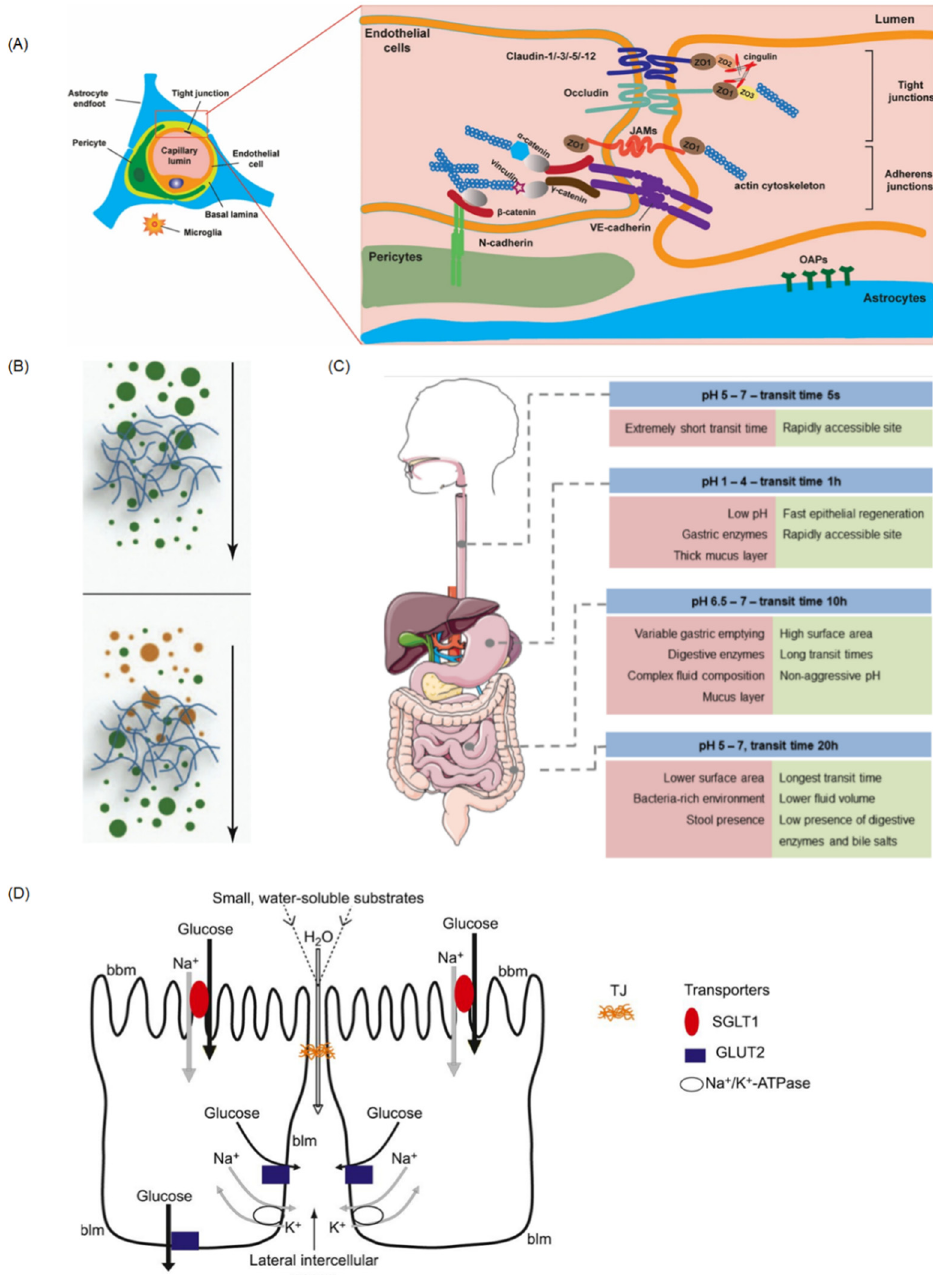
Figure 4. ( A ) Cells association at and molecular organization of the neurovascular unit (NVU). ( B ) The steric ( left ) and interactive ( right ) barrier properties of mucus. The mucus forms a filter, which can prevent diffusion across the gel according to size ( left ) or surface properties ( right ) of the diffusing compound. ( C ) Schematic representation of GIT sections and their pH, transit time, and relevant parameters for drug delivery. ( D ) Schematic diagram illustrating glucose absorption by transcellular pathways and paracellular pathways. Reprinted and adapted with permission from: ( A ) Kadry et al. [89], ( B ) Lieleg et al. [108], ( C ) Alonso et al. [129], and ( D ) Karasov et al. [130].